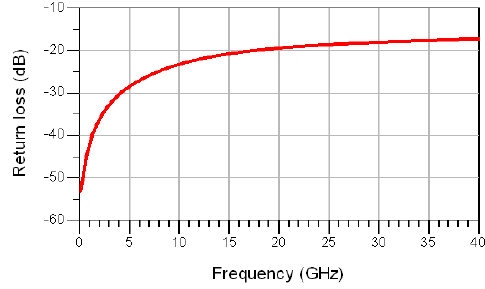
Figure 12. Return loss of the micromachined switch.